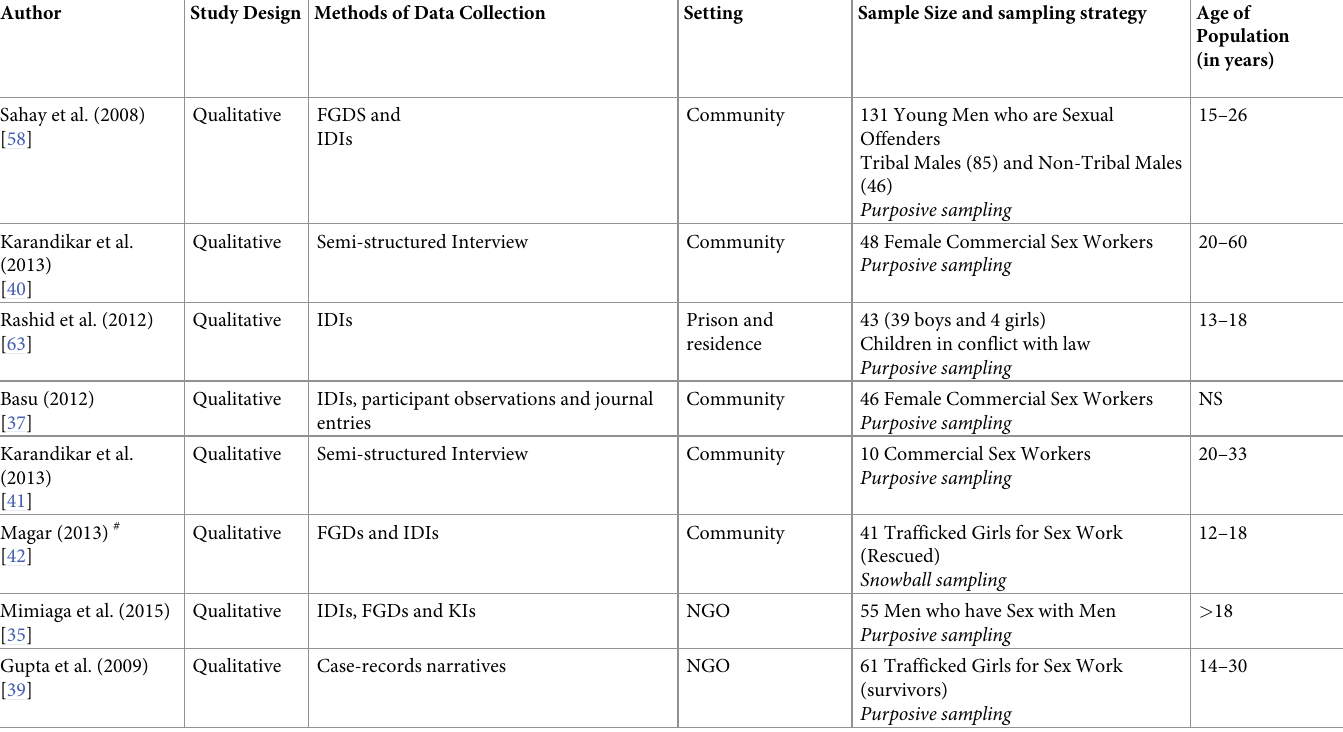
Table 9. Summary of qualitative studies and mixed-methods studies included in the